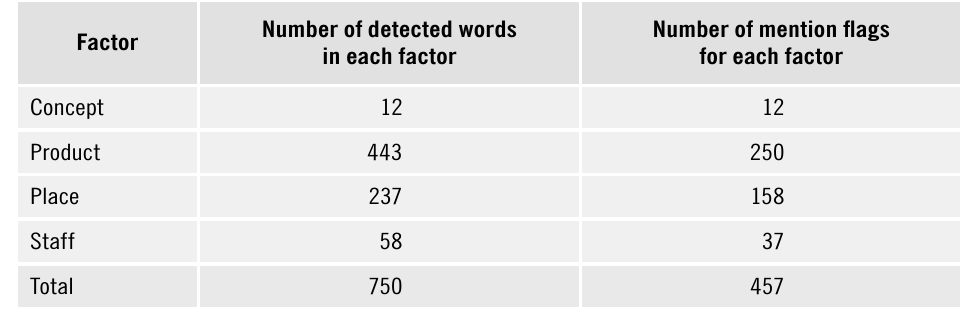
Table 2. Number of detections of each factor